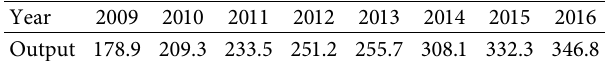
Table 1: Outputs of municipal solid waste (MSW) in Xi’an (ten thousand